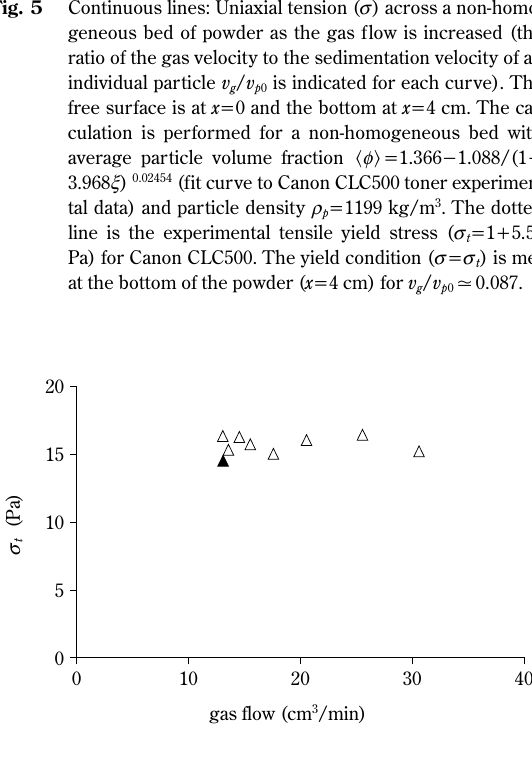
Fig. 6 Uniaxial tensile yield stress measured by increasing quasi- statically the gas flow (solid triangle) and by imposing instantaneous values (void triangles) of the gas flow repre- sented in the horizontal